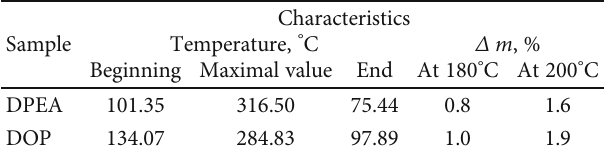
Figure 1: TGA curve of the plasticizer of DPEA. Table 2: The results of the thermal analysis of